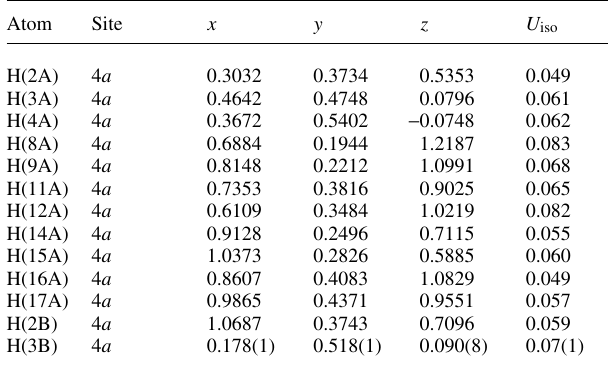
Table 2. Atomic coordinates and displacement parameters (in Å 2 )